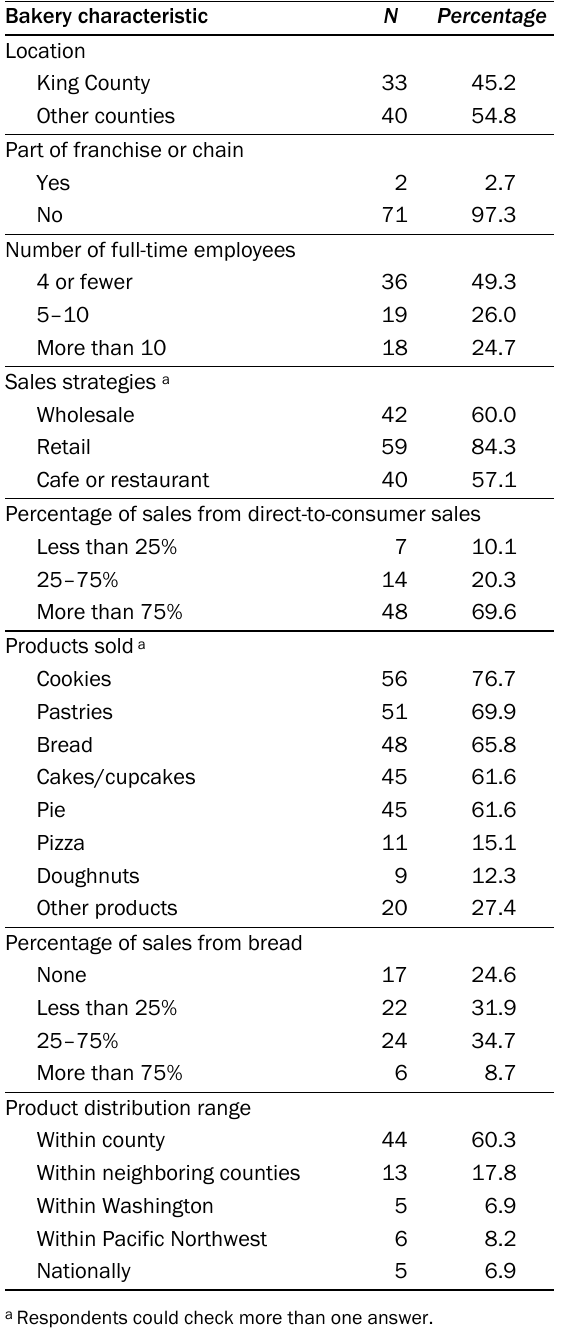
Table 1. Descriptive Statistics for